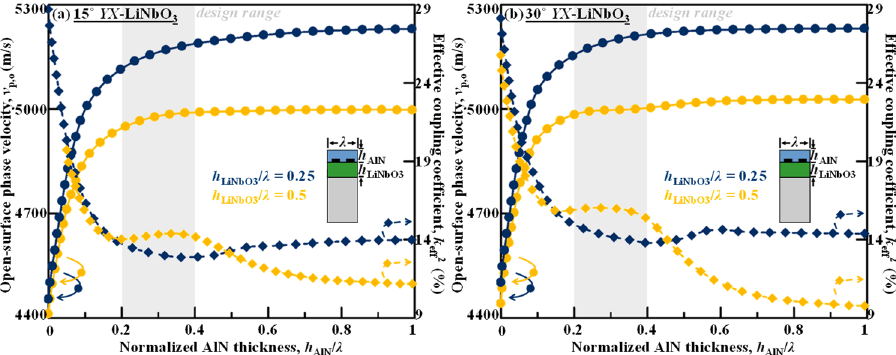
Figure 7. Trade-offs between the open-surface phase velocities v p,o and coupling coefficient k eff2 by varying AlN thickness for the SH wave propagating in AlN/ LiNbO 3 /Si based on ( a ) 15° YX -LiNbO 3 and ( b ) 30° YX -LiNbO 3 with h LiNbO3 / λ = 0.25 and h LiNbO3 / λ = 0.5.